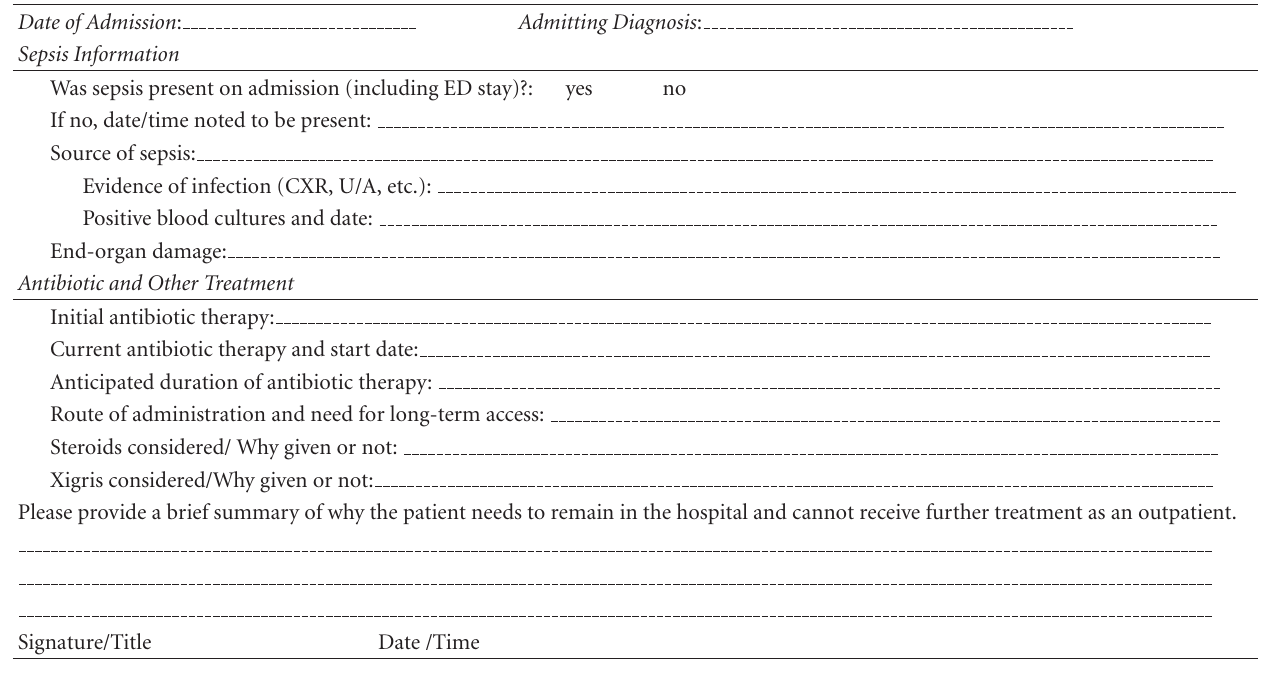
Table 8: Sepsis patient daily progress